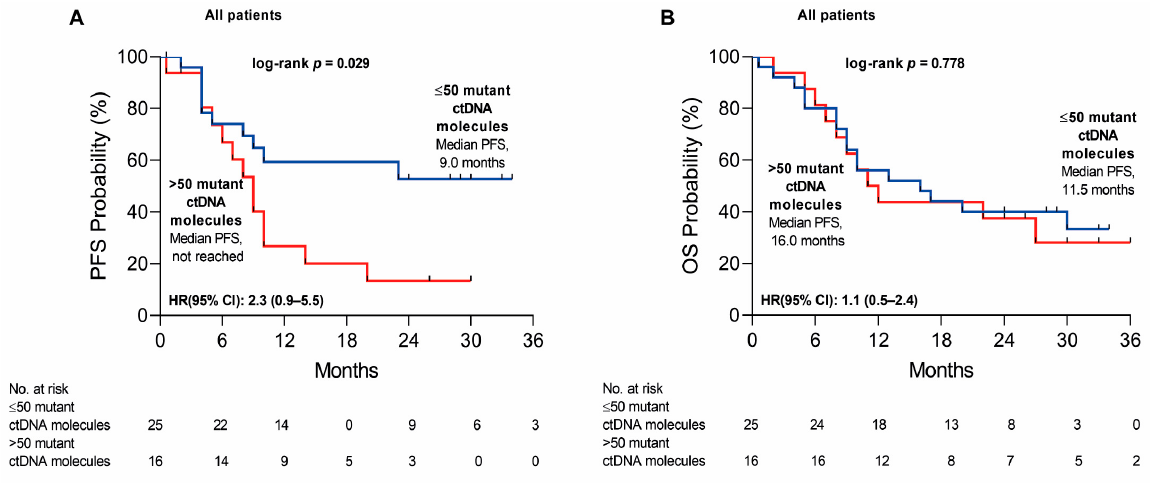
Figure 5. Kaplan–Meier estimates of progression-free survival (PFS) ( A ) and overall survival (OS) ( B ) according to median cfDNA load in high (>50 mutant cfDNA molecules) and low cfDNA load ( ≤ 50 mutant cfDNA molecules) patient groups; blue color indicates low cfDNA load ( ≤ 50 mutant cfDNA molecules) and red—high cfDNA load (>50 mutant cfDNA